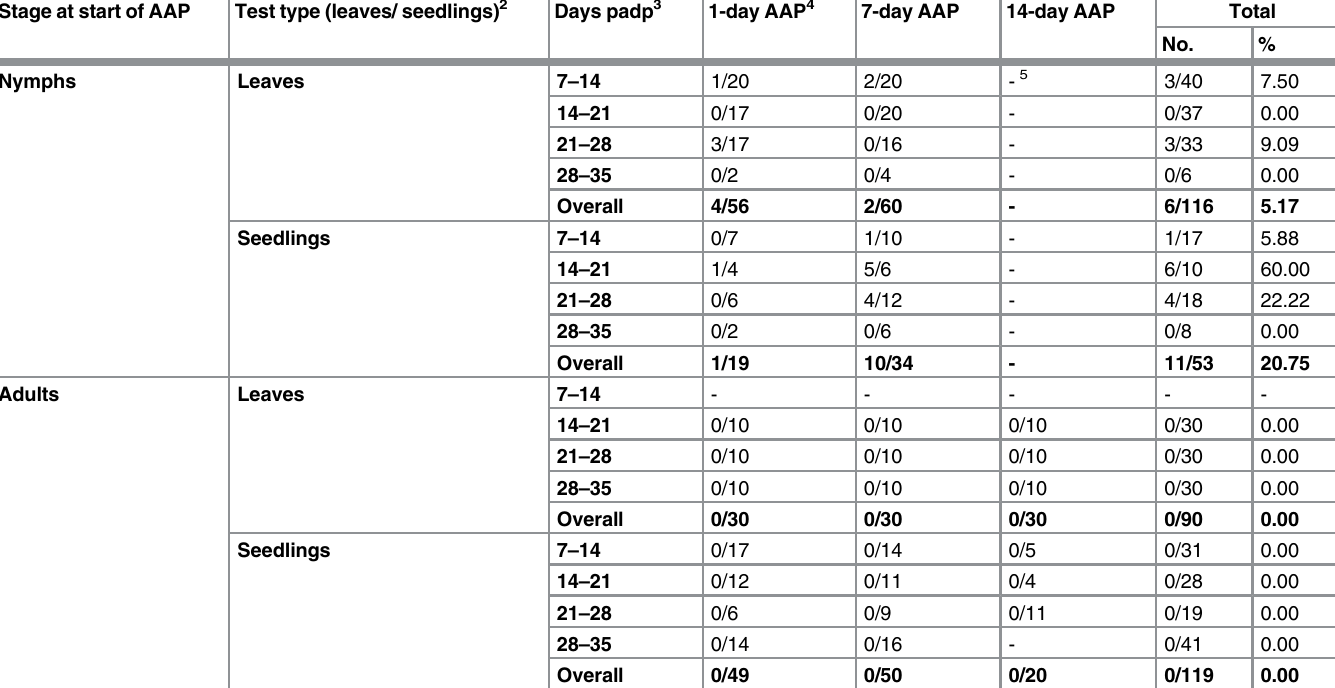
Table 6. Las inoculation/transmission by psyllids: Results of inoculativity tests on D . citri that fed as nymphs or adults on Las-infected citrus plants for an acquisition access period (AAP) of 1, 7 or 14 days, then tested weekly for Las inoculation into healthy sweet orange seedlings or